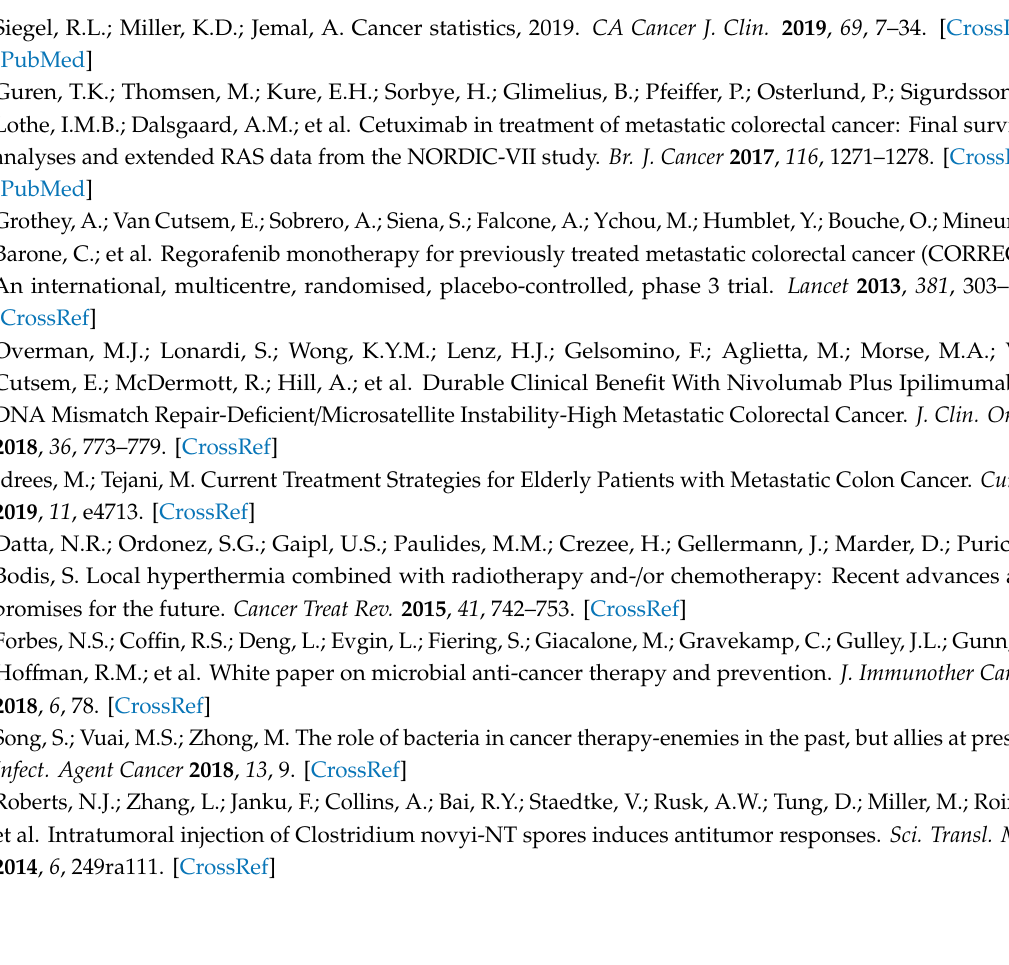
Figure S1: In vivo DSFE imaging of normal mouse colon without bacterial injection; Figure S2: Ex vivo autofluorescence image of normal mouse organ without bacterial injection using